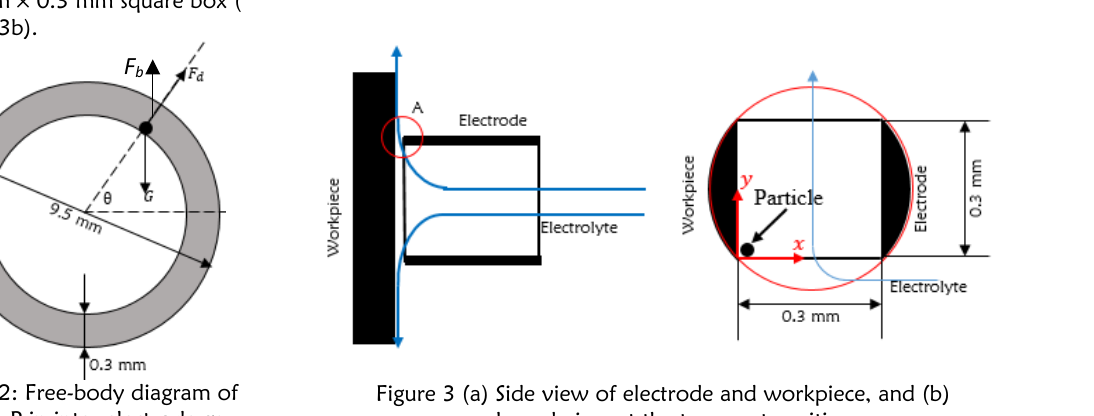
Figure 2: Free-body diagram of particle P in inter-electrode gap